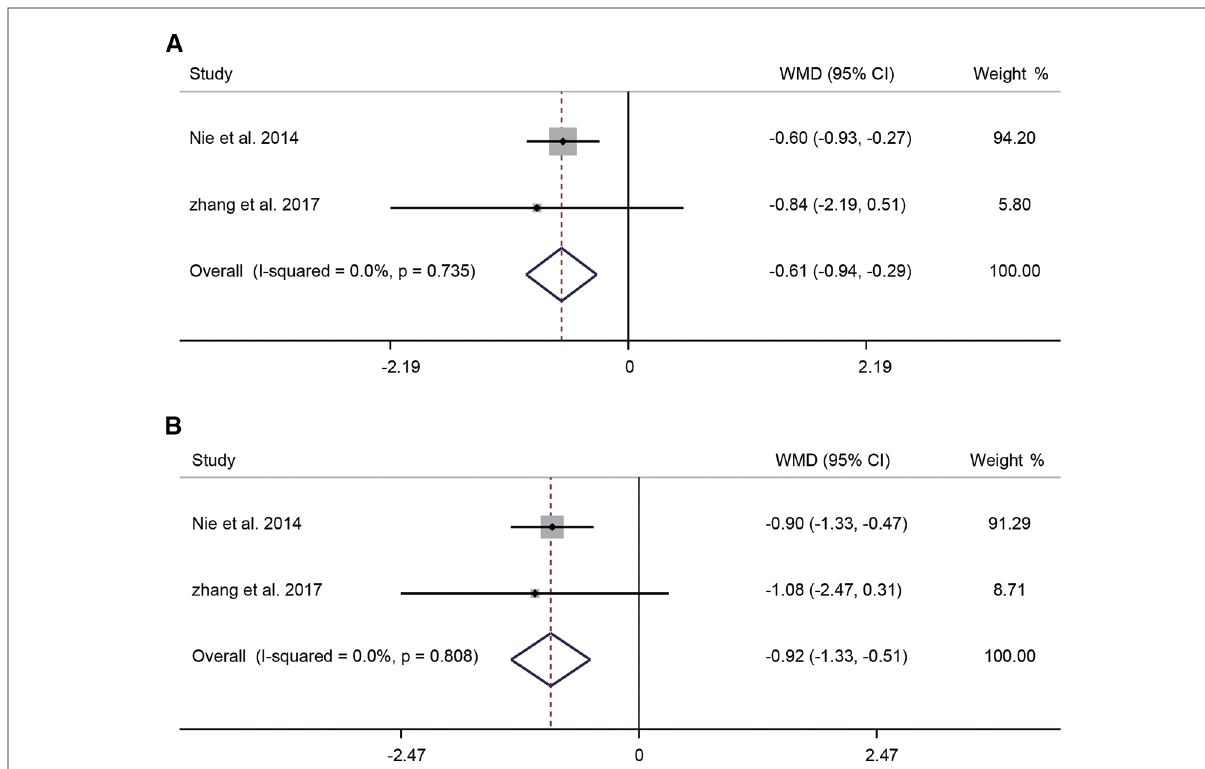
FIGURE 6 Forest plot of VAS at 6 months ( A ) and VAS at 12 months postoperatively ( B ) for the comparison of different guidance techniques (combined with other guidance techniques vs. simple image guidance). VAS, visual analog